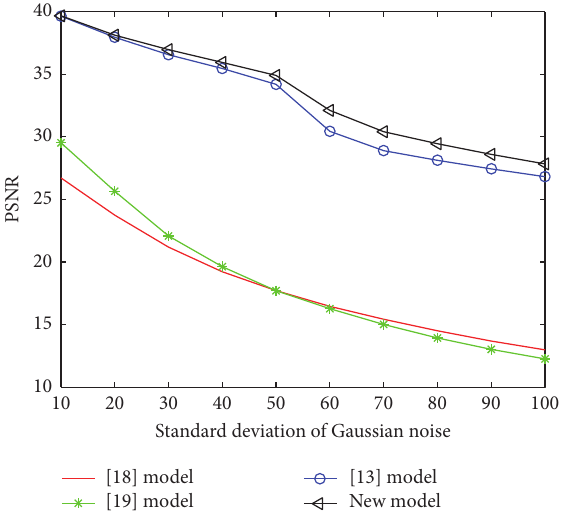
Figure 8: PSNR (dB) graph of [13, 18, 19] and new algorithms for various Gaussian noise for Salesman video